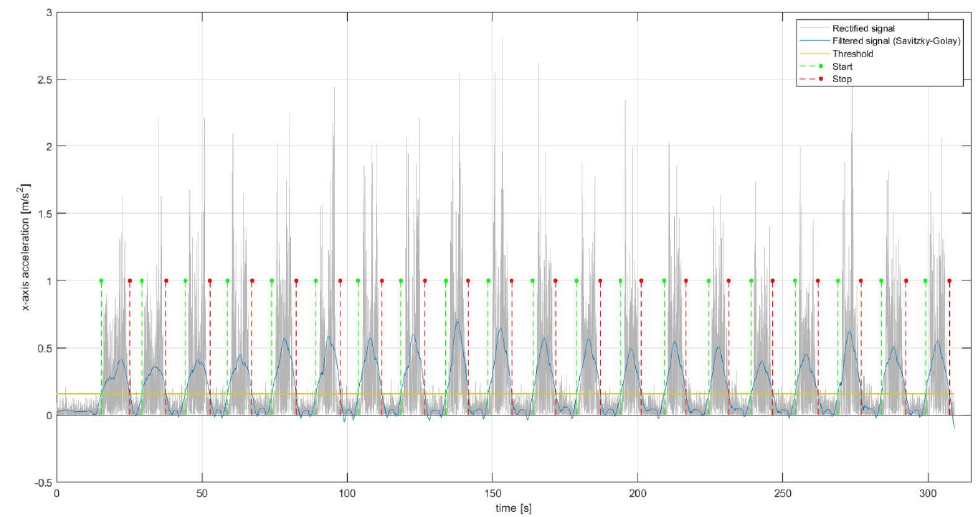
Figure 4. Determination of the ROI (start and end points) corresponding to the lifting by means of the application of Savitzky-Golay filter on the inertial signal (e.g., x -axis acceleration) and an empirical threshold.